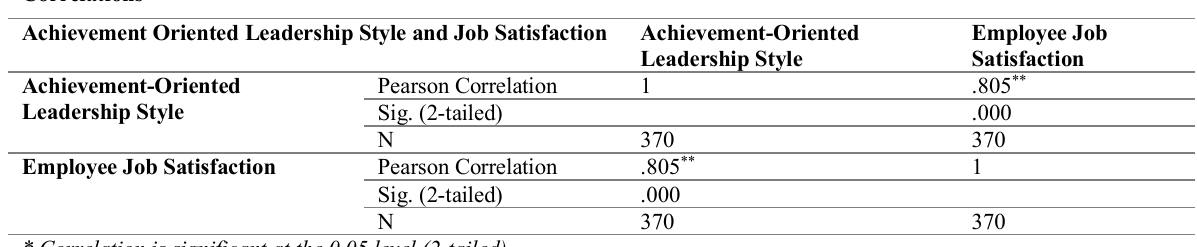
Table 7: Correlation Test for Achievement-Oriented Leadership